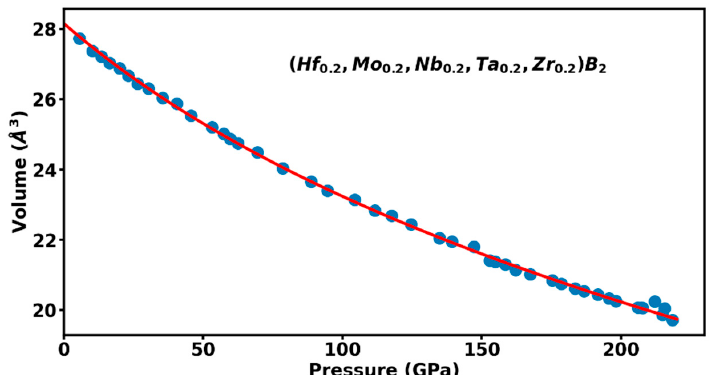
Figure 6. The measured Pressure-Volume relationship or equation of state of (Hf 0.2 Mo 0.2 Nb 0.2 Ta 0.2 Zr 0.2 )B 2 to 220 GPa or volume compression V / V 0 = 0.7. The solid curve is the third order Birch-Murnaghan equation of state fit to the experimental data and the fit parameters are described in the text.